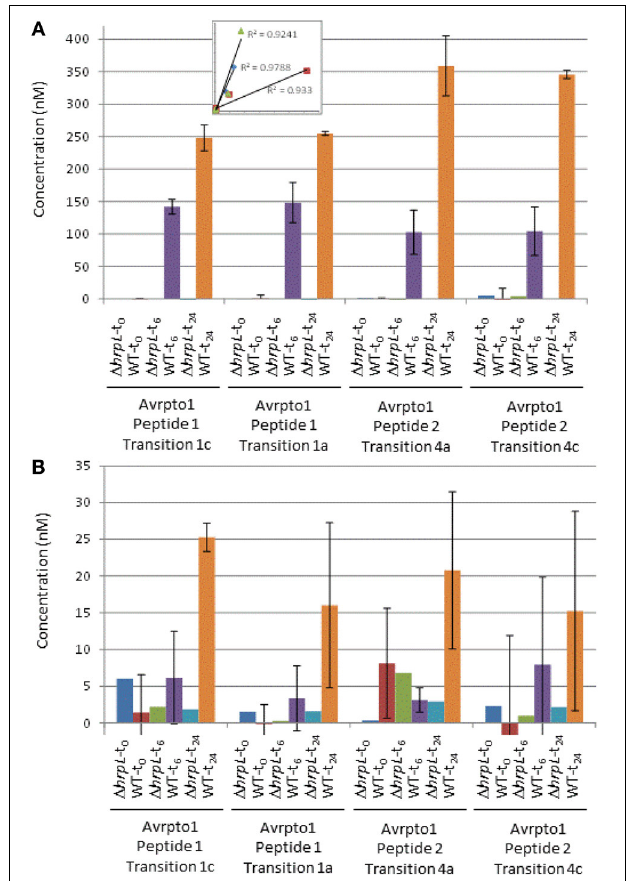
FIGURE 1 | Absolute quantification of AvrPto1. Main: Absolute protein concentrations innM in the extracellular fractions (A) and cell fractions (B) from DC3000 and DC3000D hrpL after 0, 6, and 24h after induction with HIM /fructose media (pH 6.5), based on independent calculations from four transitions (as indicated). Error bars indicate one standard deviation from the mean from two biological replicates. Inset in Figure 1A shows the correlation of extracellular fraction sample peak intensities between AvrPto1 transitions and peptides (see text).